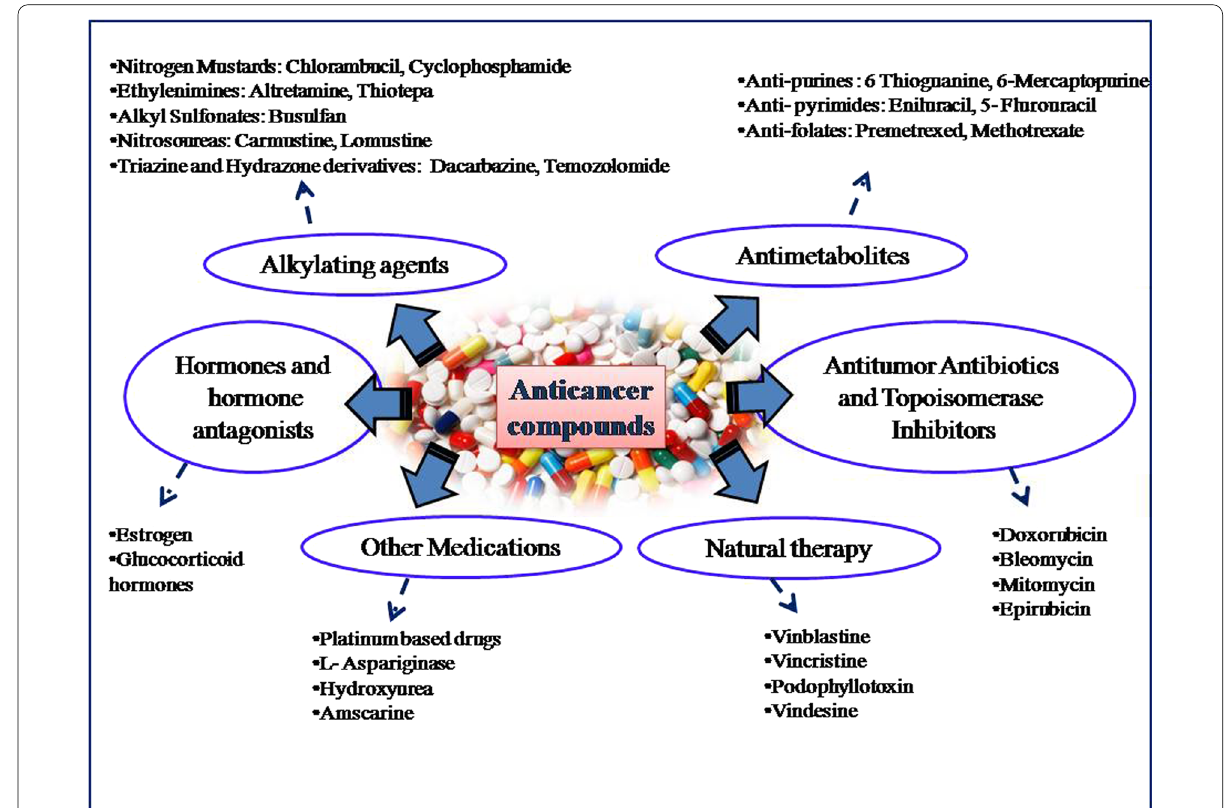
Fig. 1 Classification of anticancer